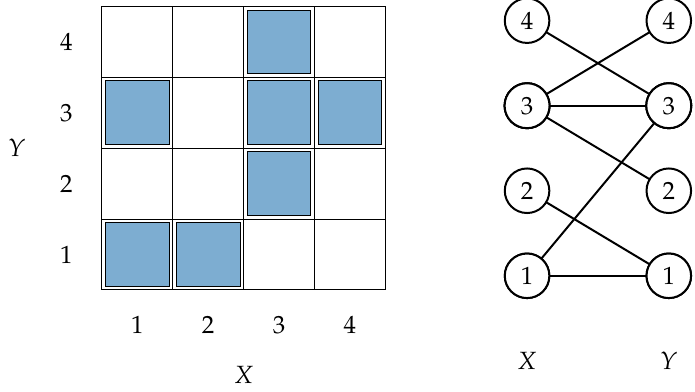
Figure A1. Representation of a subset Γ ⊂ X × Y (left) as a bipartite graph (right). The graph is a connected